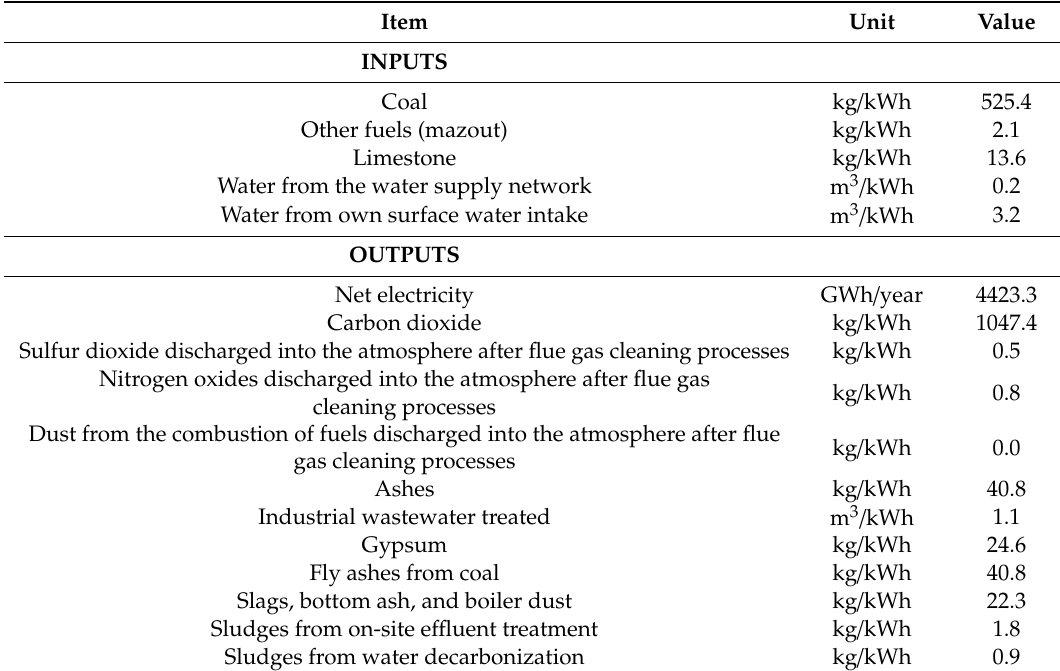
Table 1 summarizes the values of input and output data per 1 MWh of net electricity generated. These are the average values from 2018. Summary of the input and output data values per 1 MWh of the net generated electricity—average values from